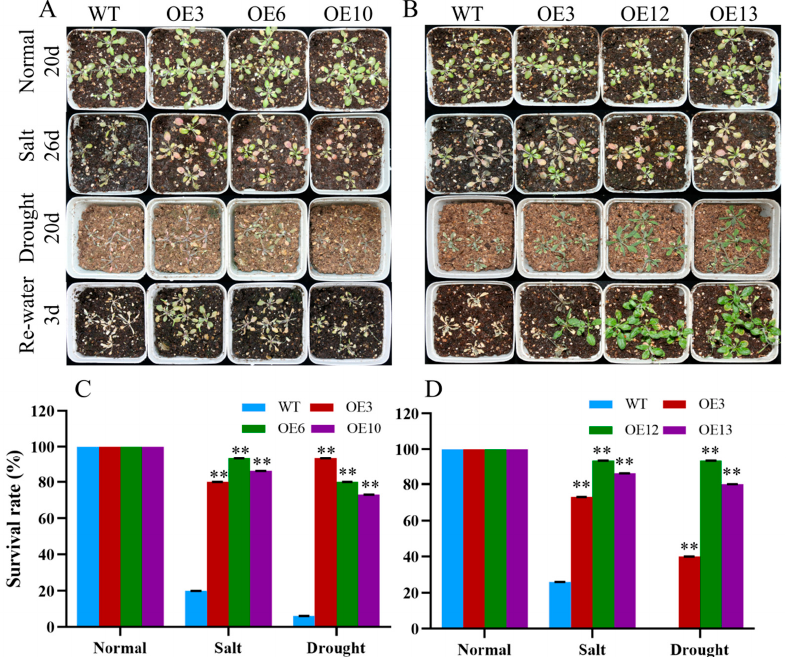
Figure 10. Phenotypes of WT and MiCOL16A and MiCOL16B transgenic plants under abiotic stresses. Normal, control; salt, 300 mM NaCl solution applied every 2 days; drought, withholding of water. ( A ) WT and MiCOL16A transgenic plants under different stresses. ( B ) WT and MiCOL16B transgenic lines under different stresses. ( C – D ) Survival rates of the WT and the MiCOL16A ( C ) and MiCOL16B ( D ) transgenic lines under different stresses. Significant differences among the samples were assessed at the p < 0.01 (**) levels by Student’s t tests. To explore the molecular mechanism underlying these phenomena in the transgenic lines in response to salt or drought, four stress-related genes were selected: AtNHX1 , AtRD20 , AtSOS1 and AtCOR15A (Figure 11). Under salt stress, the expression levels of AtNHX1 , AtRD20 and AtSOS1 were significantly higher in the three transgenic lines of MiCOL16A than in the WT, but in the MiCOL16B transgenic lines, the expression level of AtRD20 was not significantly higher (Figure 11A,B). Under drought conditions, the ex- pression levels of AtCOR15A , AtRD20 and AtNHX1 in the MiCOL16A and MiCOL16B transgenic lines were significantly higher than those in the WT (Figure 11C,D). These find- ings showed that by regulating the expression of stress-responsive genes, the MiCOL16A and MiCOL16B genes might increase the stress tolerance of transgenic plants under drought or salt stress.